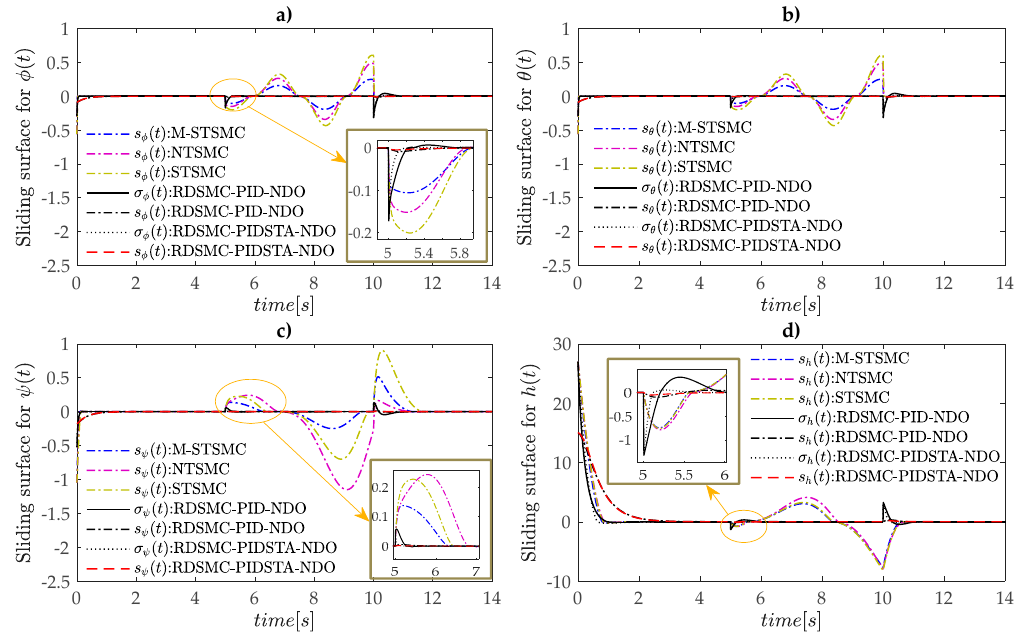
Figure 7. Comparison the sliding surfaces of attitude and altitude controller between the proposed RDSMC-NDO method and other approaches: ( a ) roll control; ( b ) pitch control; ( c ) yaw control; and ( d ) altitude control.